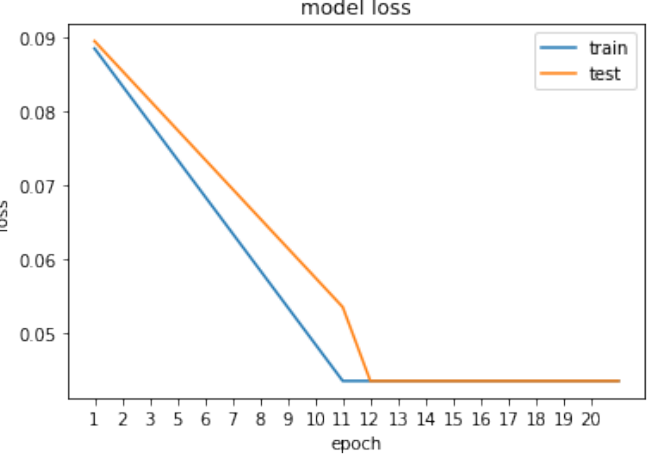
Figure 8. Loss of the proposed model during training and testing using IXMAS